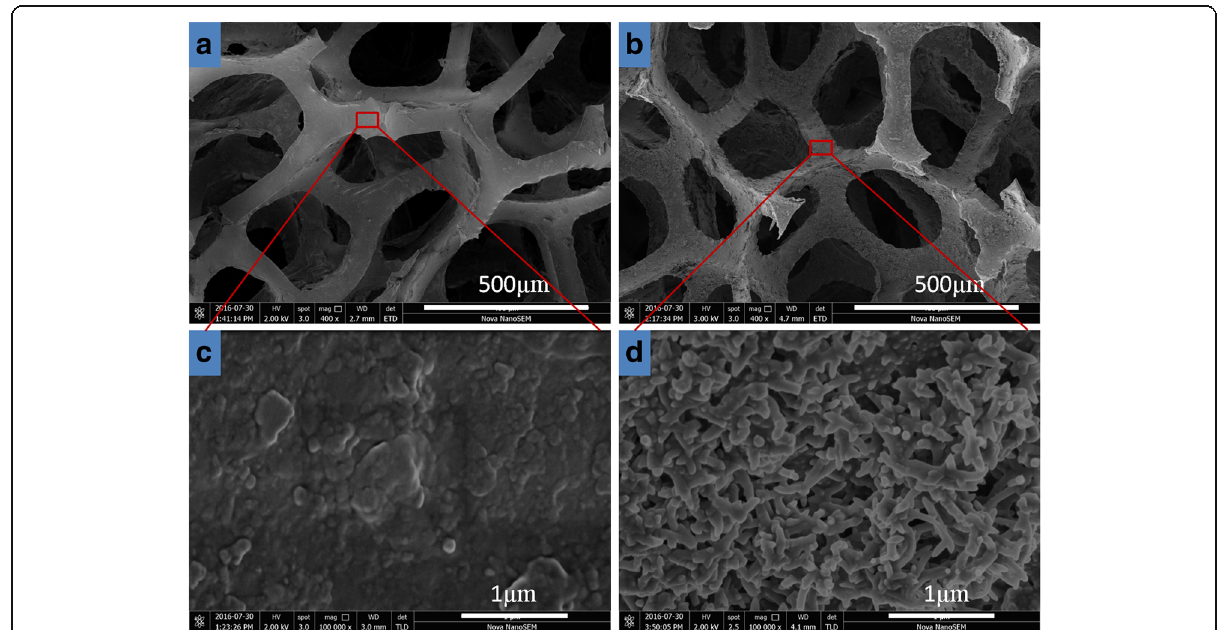
Fig. 3 SEM images of a , c pristine sponge and b , d sponge after in situ